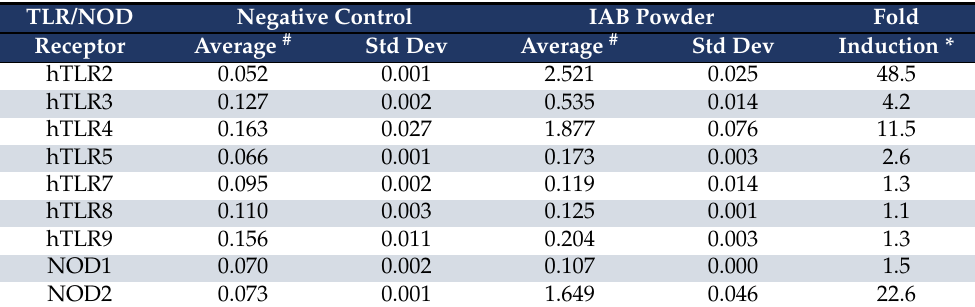
Table 1. InvivoGen TLR (Toll-like receptor) and NOD (nucleotide-binding, oligomerization domain- containing protein) receptor activation